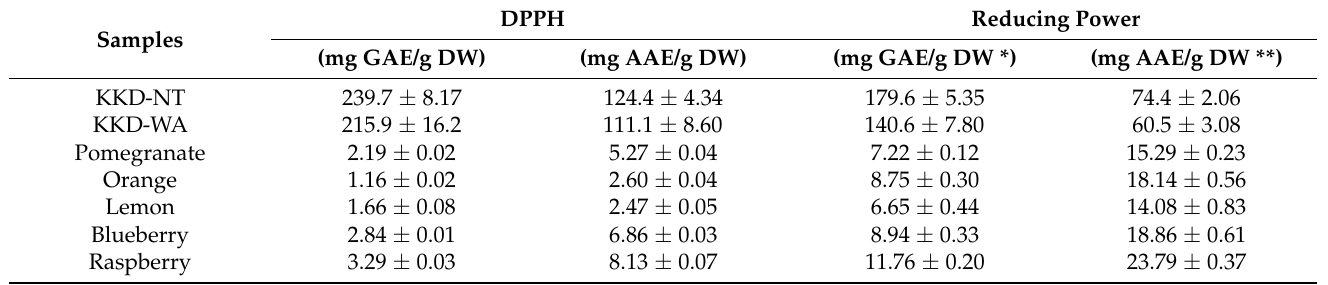
Table 4. Potential antioxidant activities of KKD-NT and KKD-WA.